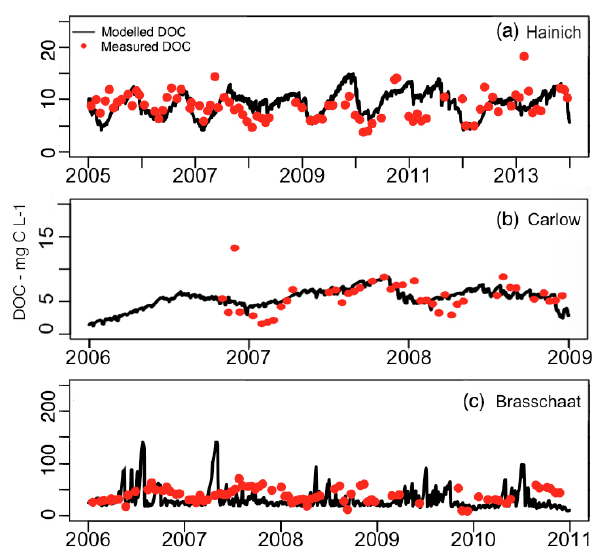
Figure 3. DOC concentration (mgCL − 1 ) at 10cm of depth mea- sured (red dots) and simulated (black lines) for (a) Hainich, (b) Car- low, and (c) Brasschaat. Results for other depths are given in Fig.